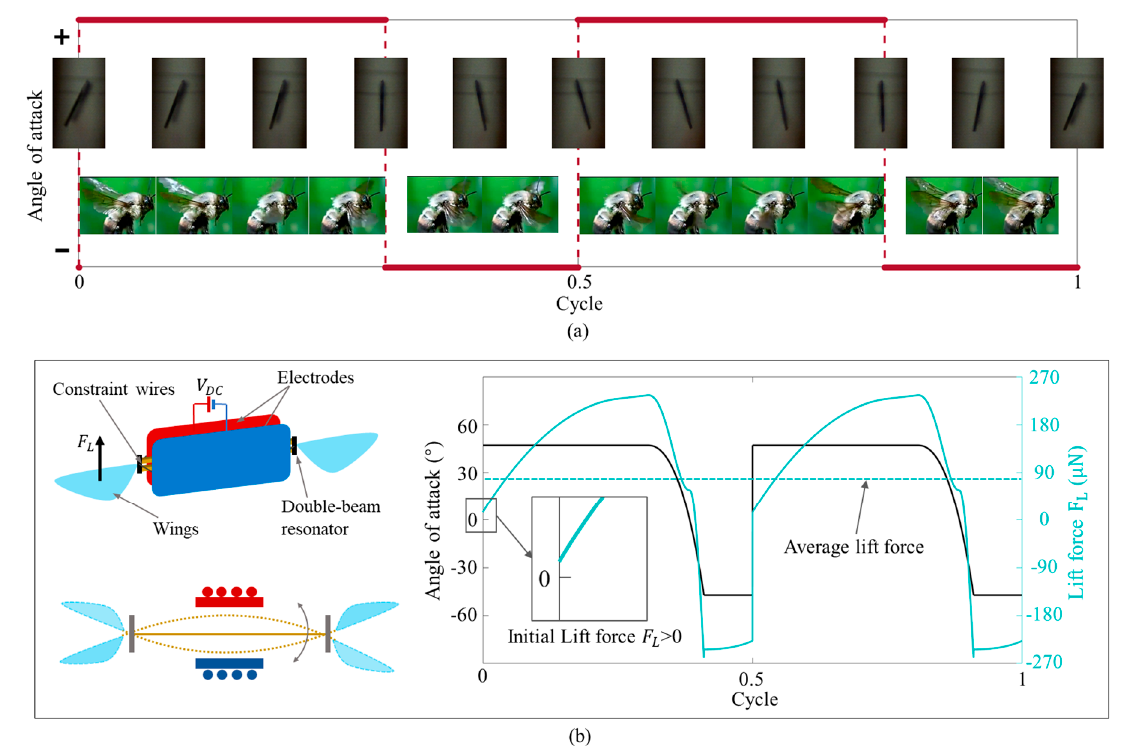
Figure 9. Advanced rotation control of flapping wings achieved by double-beam structure. ( a ) Photos of the advanced rotation of the double-beam structure compared with the bees’ wings. ( b ) Schematics of double-beam structure with flapping wings. Lift force and flapping attack angle of the double-beam resonator. The camera is posed in position 3, shown in Figure 4a.